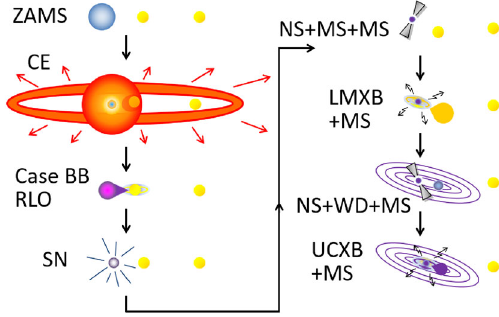
Fig. 11 Illustration of the formation of a LISA source in a triple system. See Figs. 6 and 7 for explanation of